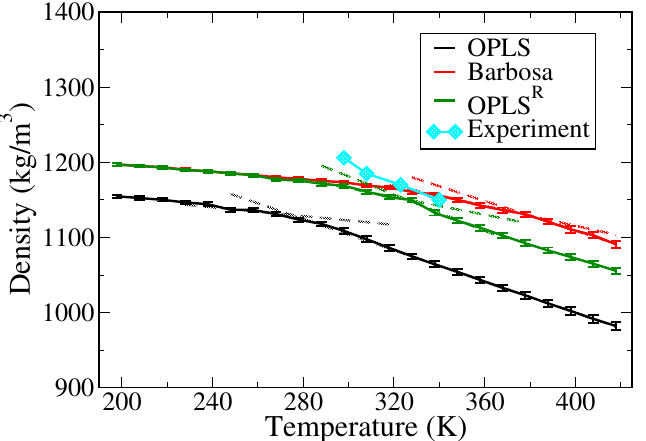
Figure 2. Comparison of experimental (cyan diamonds, data from [55]) and computed densities of pure PEO system as functions of temperature. The black data is the results of the OPLS model; the red and green curves correspond to the Barbosa and OPLS R models, respectively. Dashed lines are fitted lines in high- and low-temperature ranges for determining the transition temperature as shown later in Figure